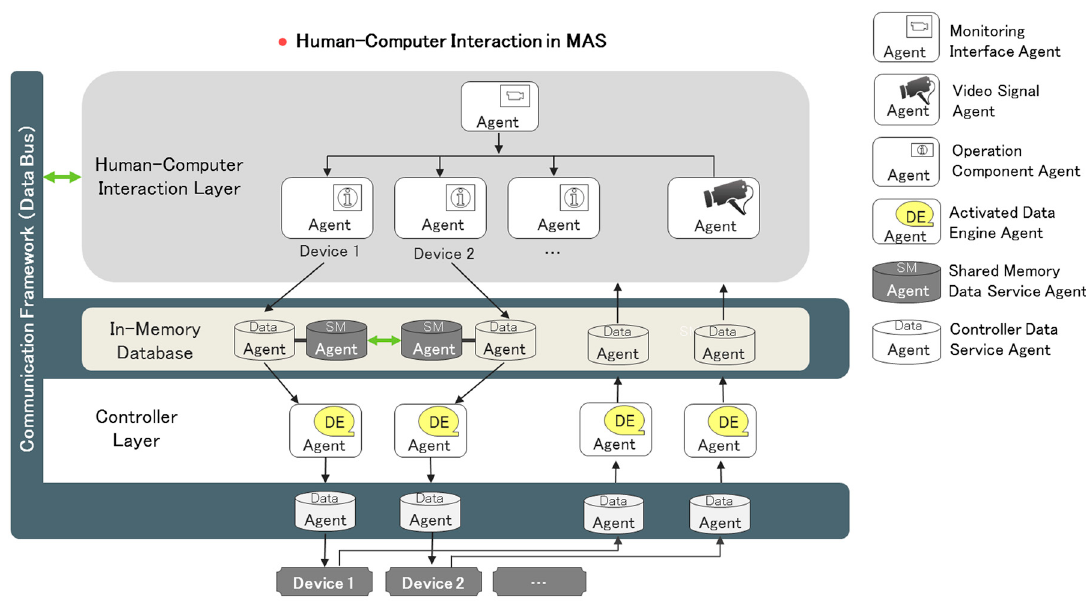
Figure 7. Human-computer interaction in the multi-agent system.